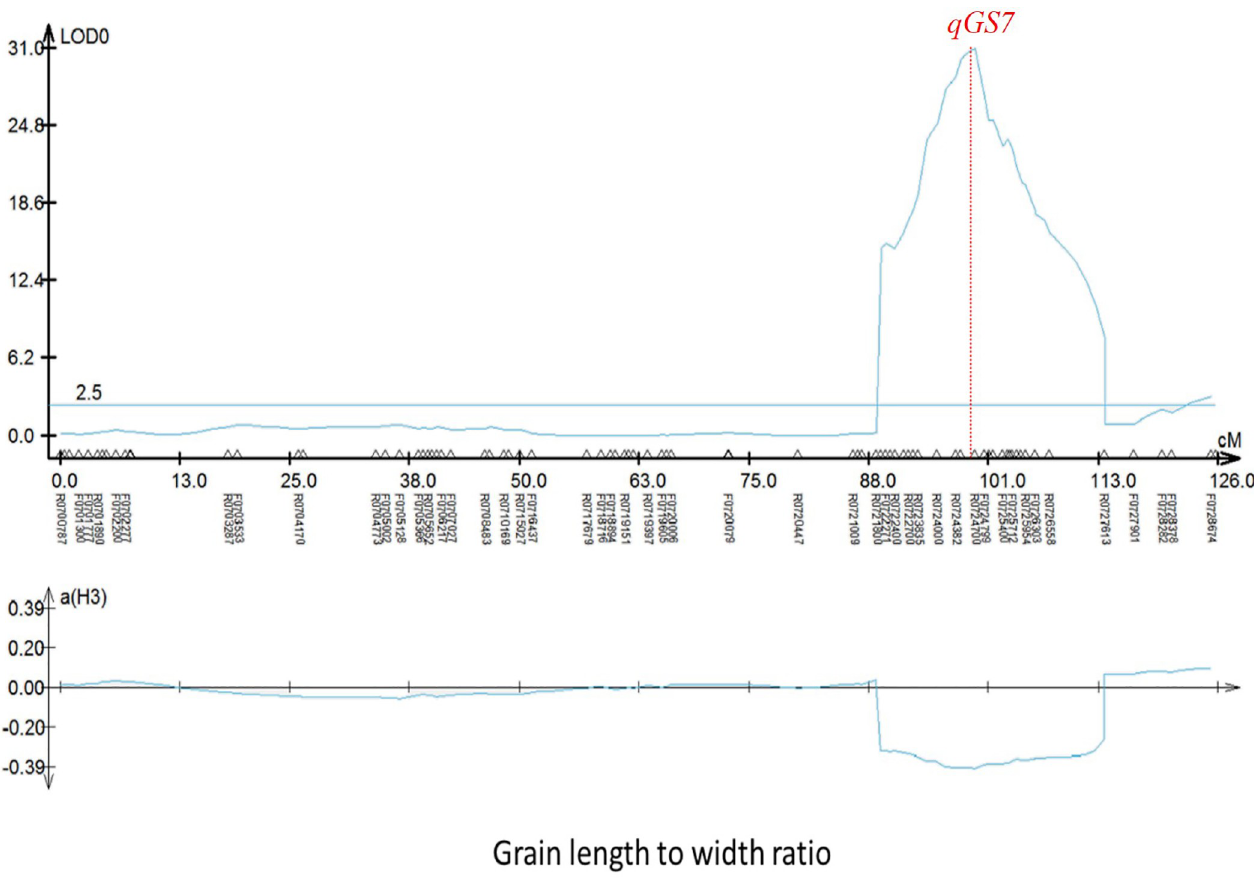
Fig 3. Local qGS7 mapping result of grain width. Red line indicates the position of the peak SNP.